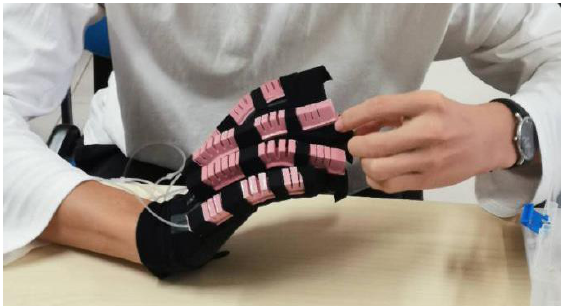
Figure 1. The design of the soft exoskeleton glove (SExoG).